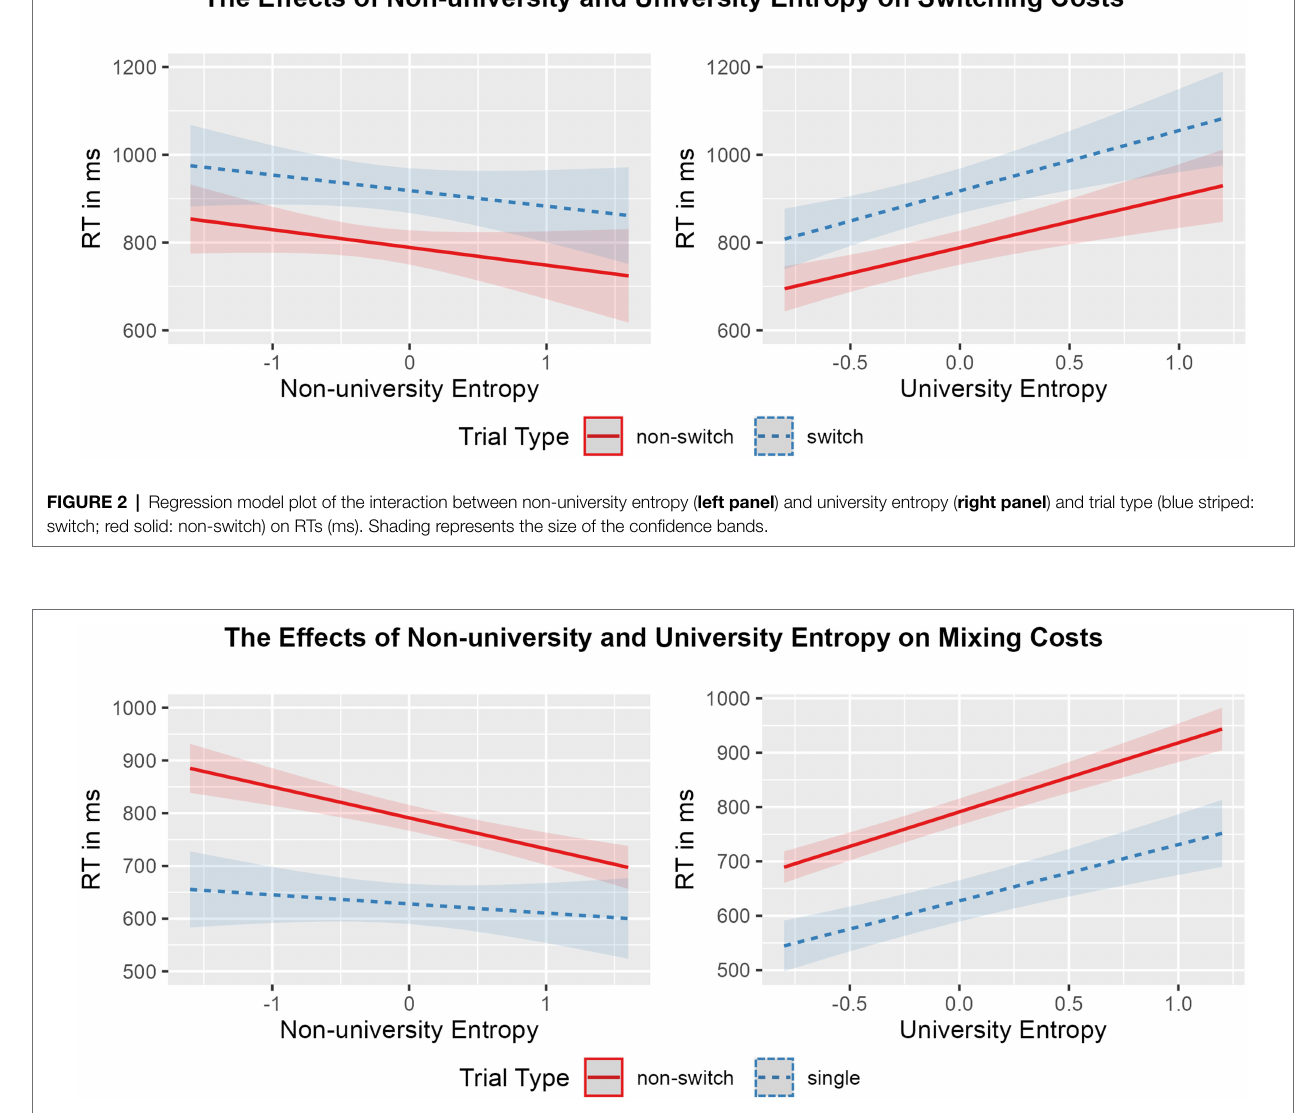
type remained significant (est = 12.481, p < 0.001), meaning that the average pupil dilation for switch trials (the reference level) remained larger than for non-switch trials. Figure 5 is a contour plot that models the difference in pupil size between the switch and non-switch trials over time, while taking into account an interaction with university entropy. Contour plots are useful in visualizing three-dimensional interactions, but it is difficult to quantify the size of the difference between switch and non-switch trials based on color alone. The solid lines in the contour plot, therefore, show us how big the difference in pupil size is between switch and non-switch trials. The dotted green and red lines represent the confidence intervals for each line. The pupil switching cost became significant slightly earlier